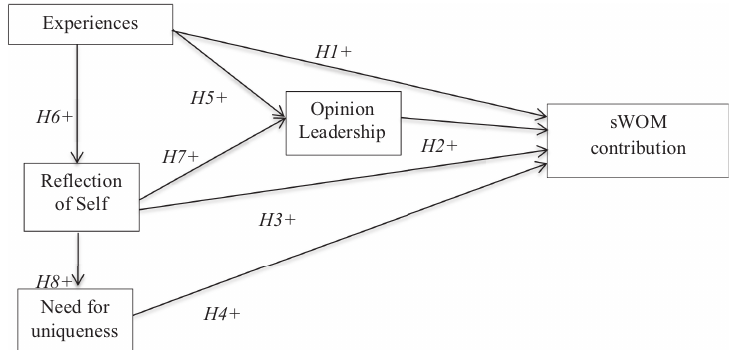
Figure 1. Proposed theoretical